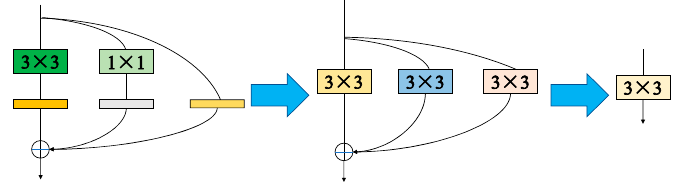
Figure 4. Schematic Diagram of Reparameterization.